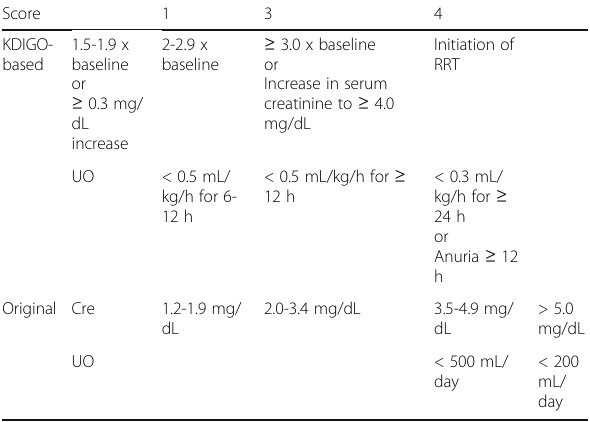
Table 1 (abstract 0065). The renal component of the KDIGO-based and original SOFA score